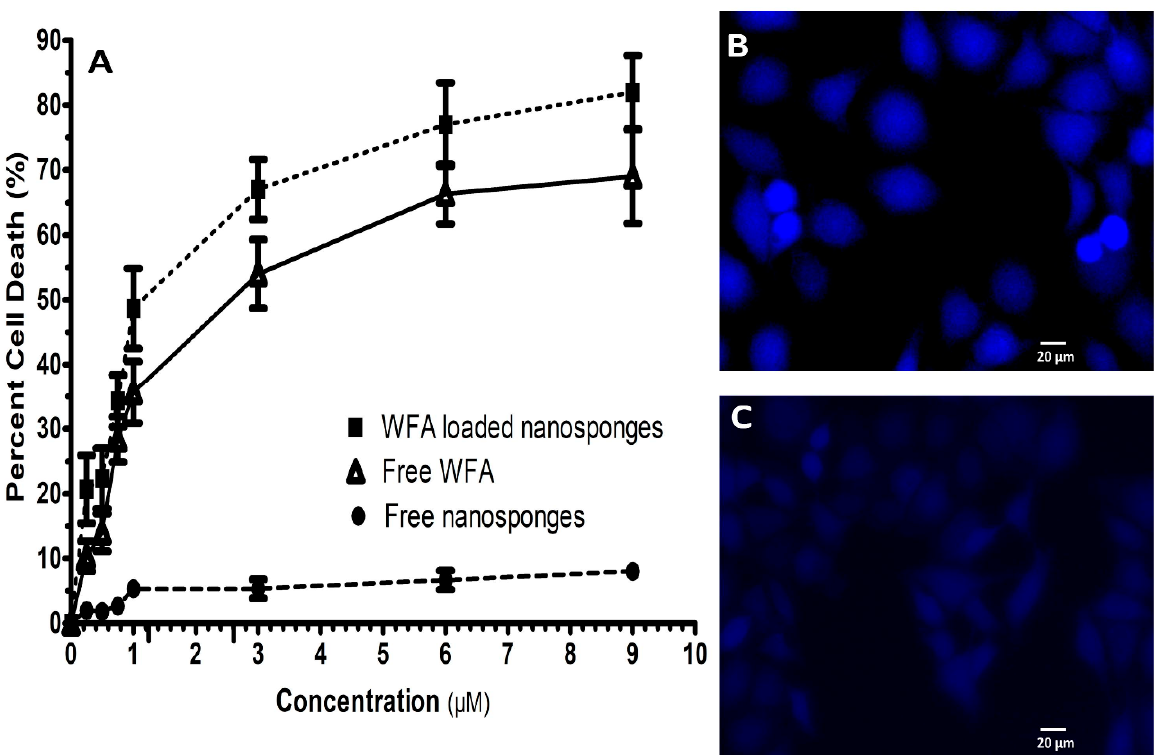
Figure 3. The pharmacological characterization of WFA-NS, pure WFA, and free NS (IC 50 data) ( A ), DAPI staining of untreated and treated MCF-7 cells ( B , C ).